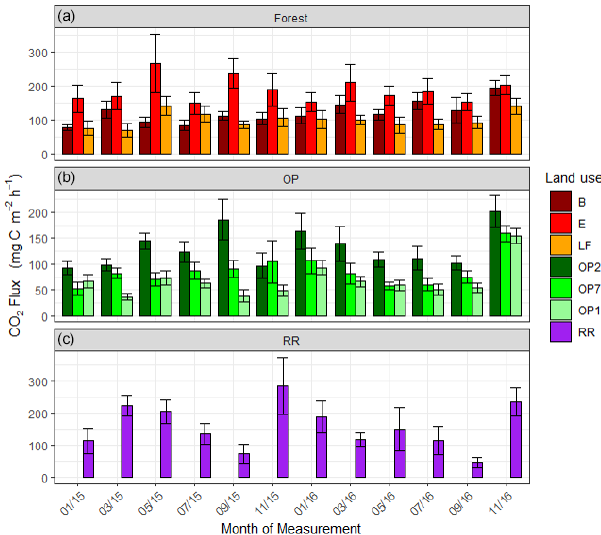
Figure 5. Methane (CH 4 -C) fluxes in µgm − 2 h − 1 from Jan- uary 2015–November 2016, every 2 months ( a B, E, LF: logged forests; b OP2, OP7, OP12: oil palm plantations; c RR: riparian reserve). Bars are the mean for each site, and error bars are the stan- dard deviation of number of chambers per site. Please note the dif- ferent y -axis scales for each land use. Due to technical issues data are missing for 15 September to 16 January.